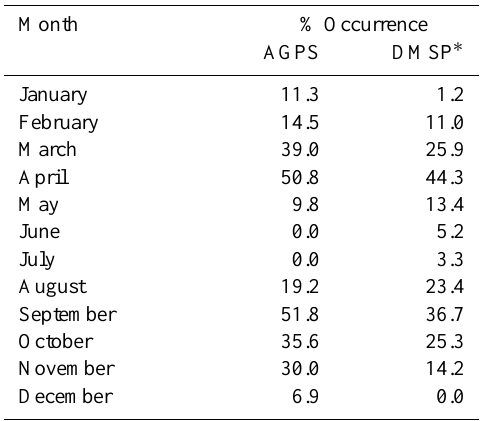
Fig. 4. Daily occurrence record of GPS scintillation with S 4 > 0.4. White indicates occurrence for any fraction of a 12-min time inter- val, black is no such occurrence, and grey indicates no operation.